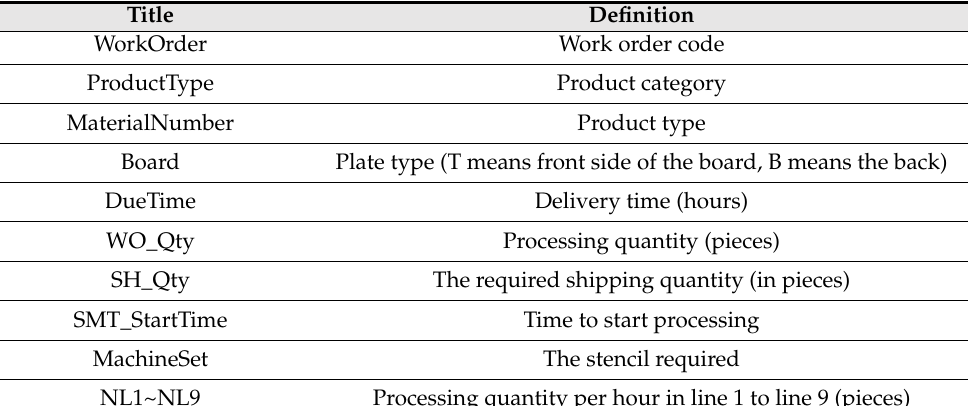
Table 2. Definition of each column of pending work order information.